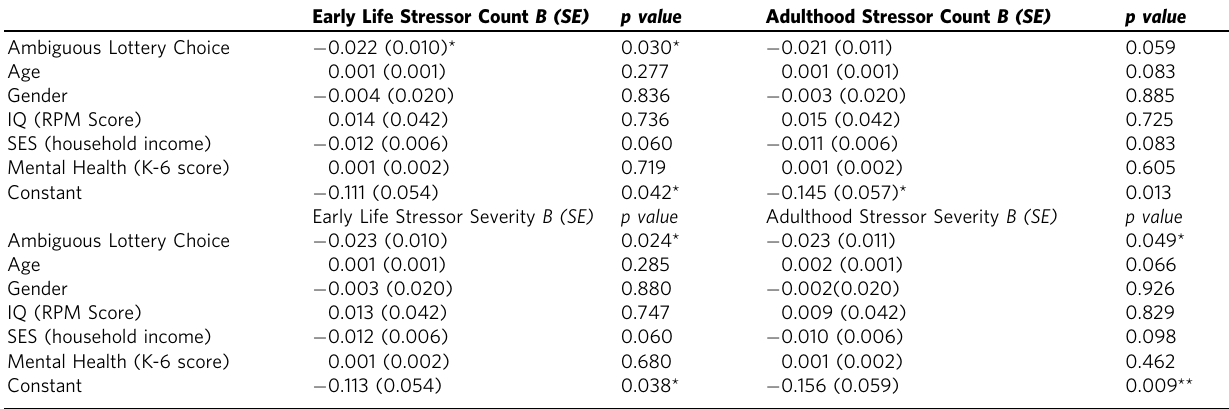
Table 3 Early life vs. adulthood total stressor exposure and ambiguous lottery choice (Study